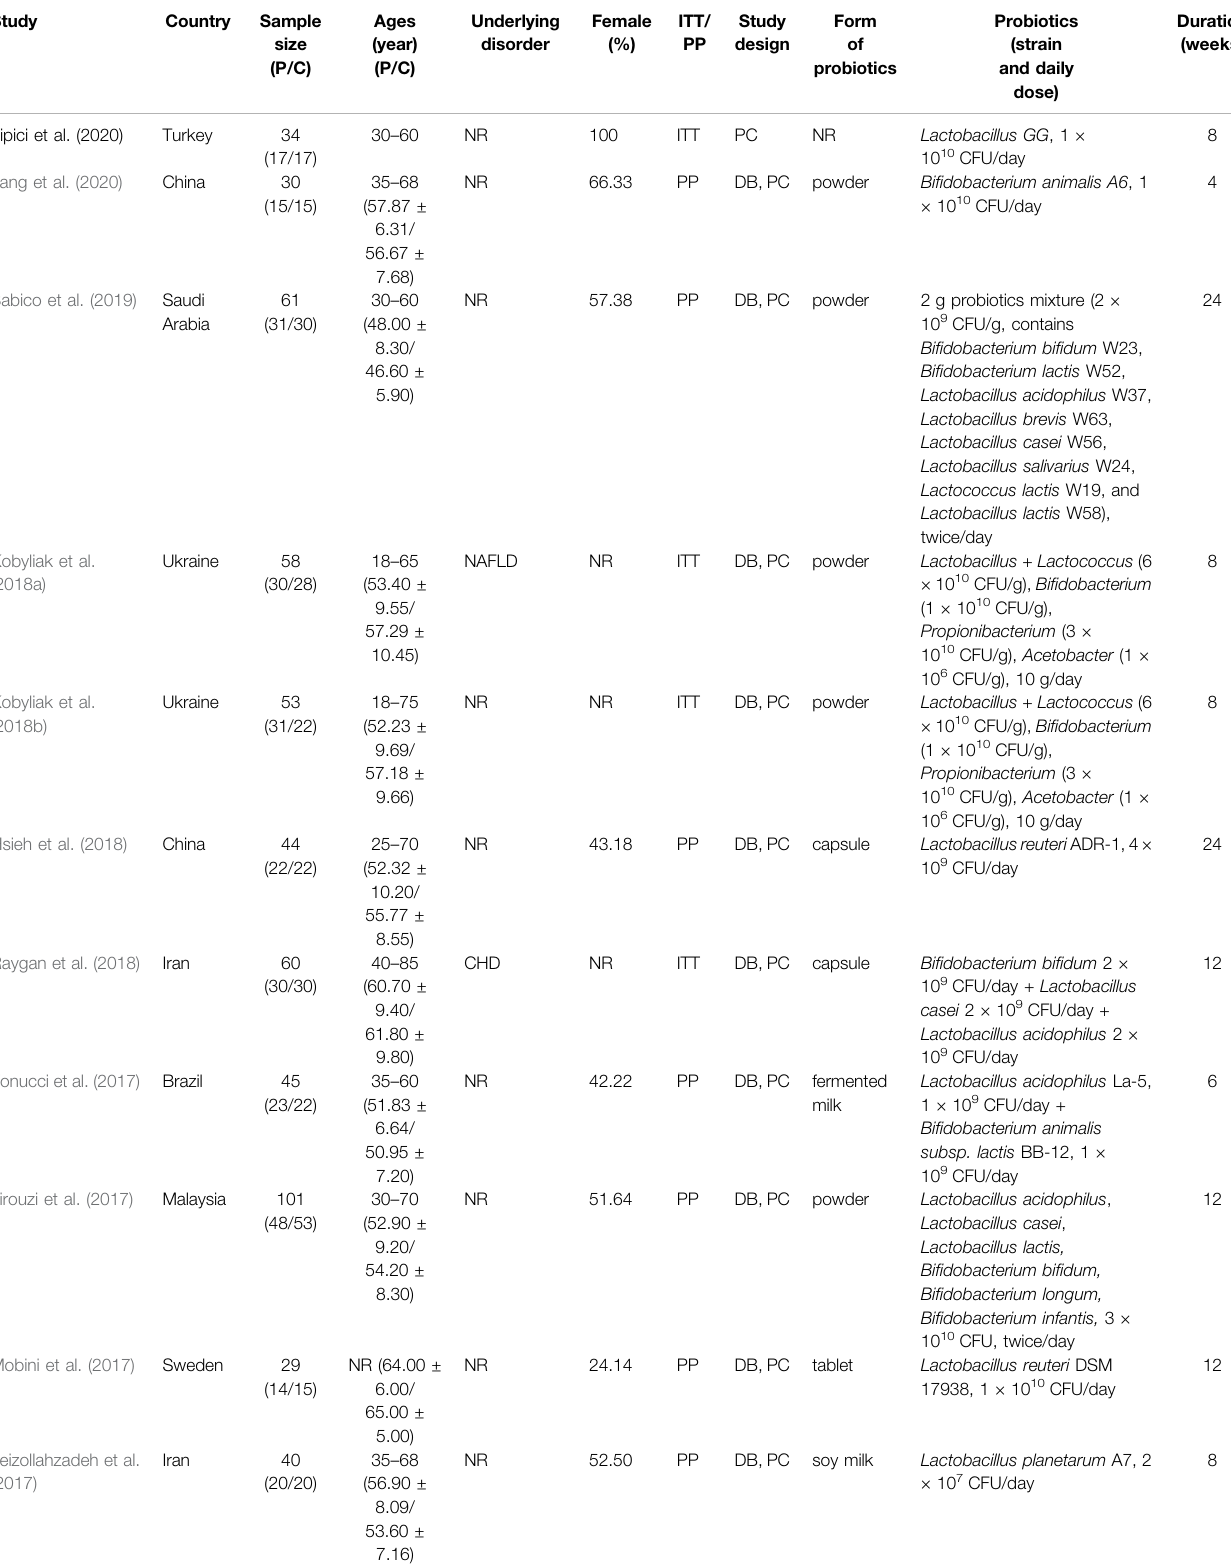
TABLE 1 | Characteristics of included